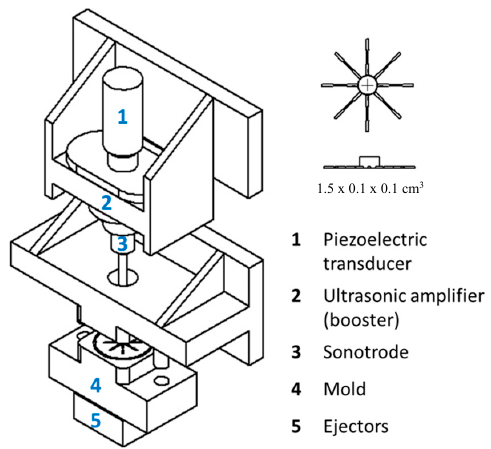
Figure 1. Diagram of the main parts of the micro-molding equipment.